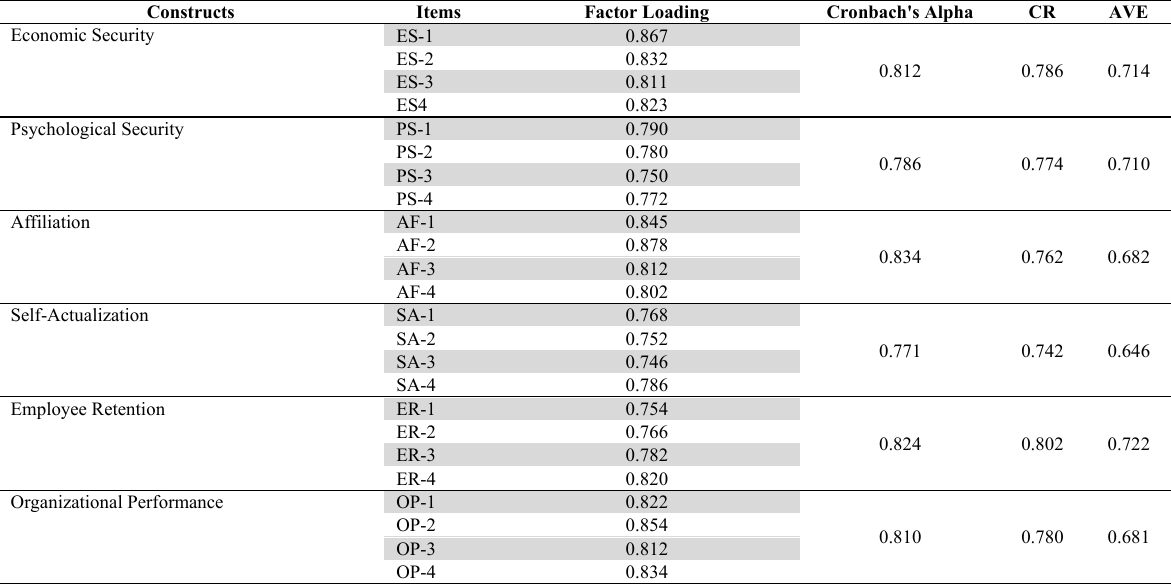
Convergent validity results, which assure acceptable values (Factor loading, Cronbach’s Alpha, composite reliability  0.70 & AVE > 0.5)